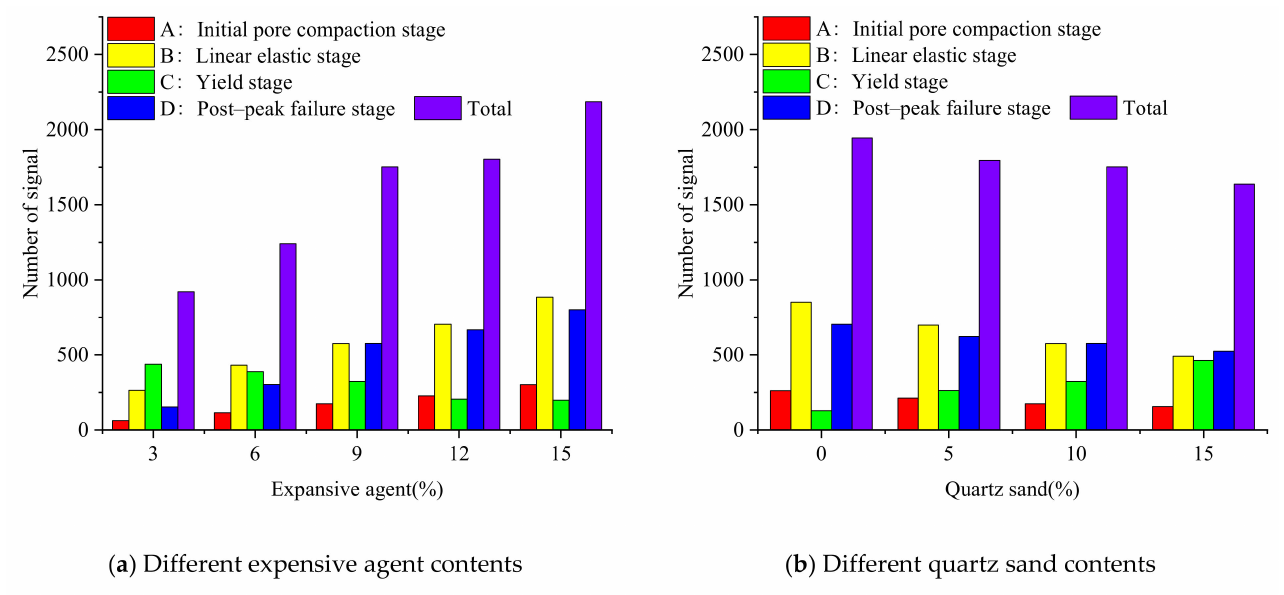
Figure 14. The number of acoustic emission signals in different failure stages